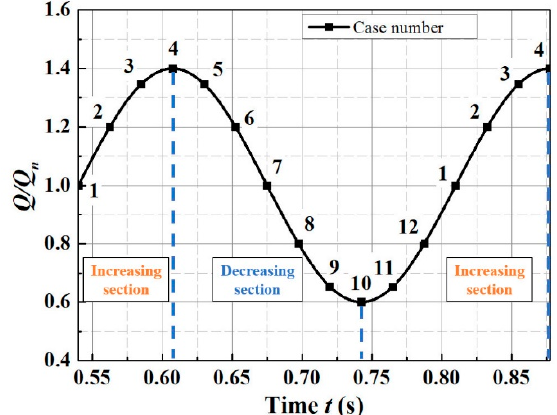
Figure 2. Sinusoidal incoming flow period division and its case distribution.